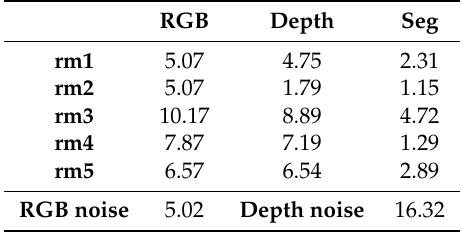
Table 3. Average durations for single image